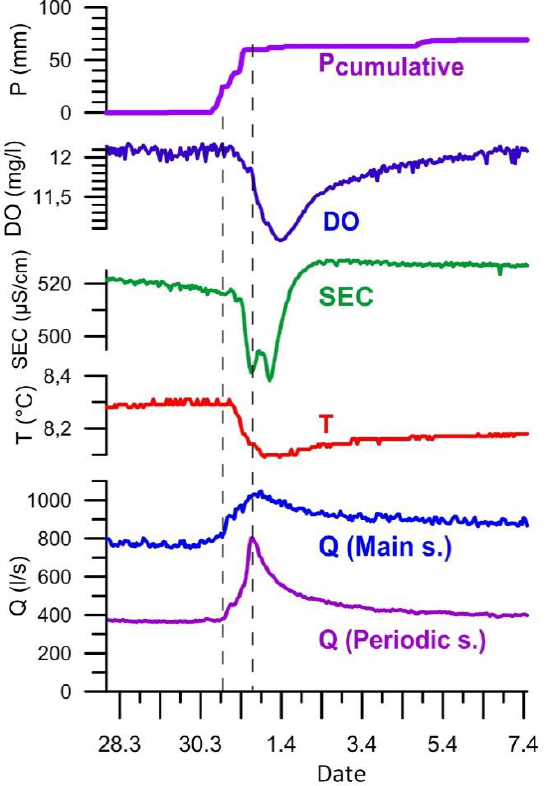
Figure 7. Detailed dynamics of the main spring temperature (T), specific conductivity (SEC) and dissolved oxygen (DO), the springs discharges (Q) and cumulative precipitation (P) during the maximum recorded flood event in March–April 2018.